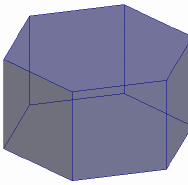
Figure 7. A hexagonal prism (D6R) consisting of 2 six-membered and 6 four-membered rings made up of TO 4 -tetrahedra (a tertiary building unit) [compiled by the authors].